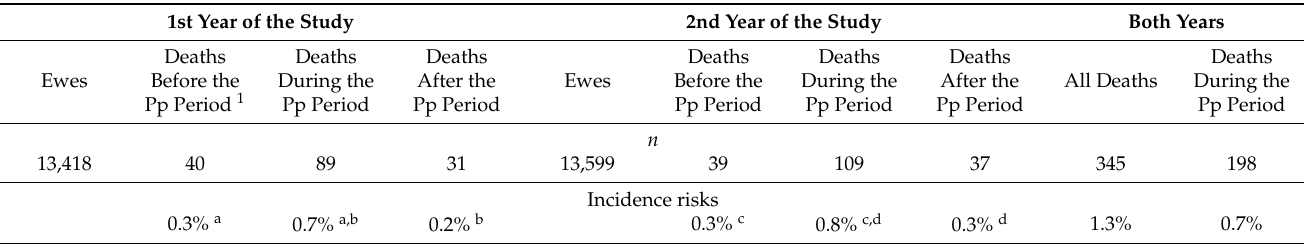
Table 1. Frequency and incidence risk of deaths of adult ewes during a two-year study in 60 sheep flocks in